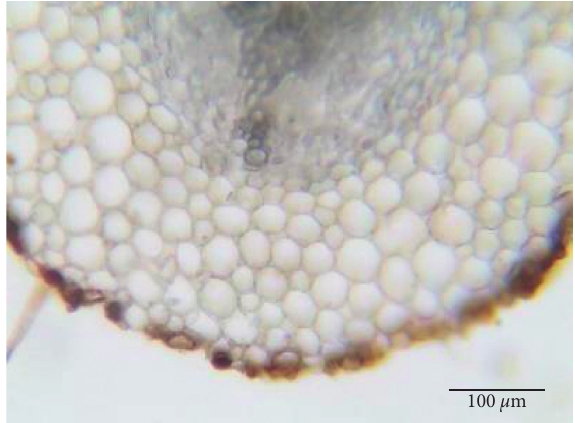
Figure 5: Main root cross section of the cedar seedling grown on the hydroponically medium. The scale bar corresponds to 100 µ m.